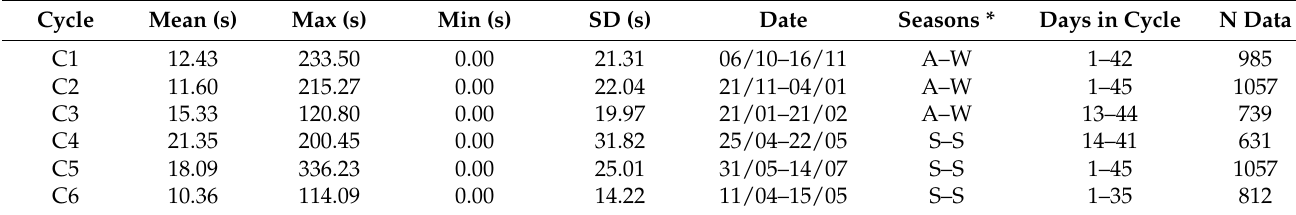
Table 1. Overview of the recorded activity